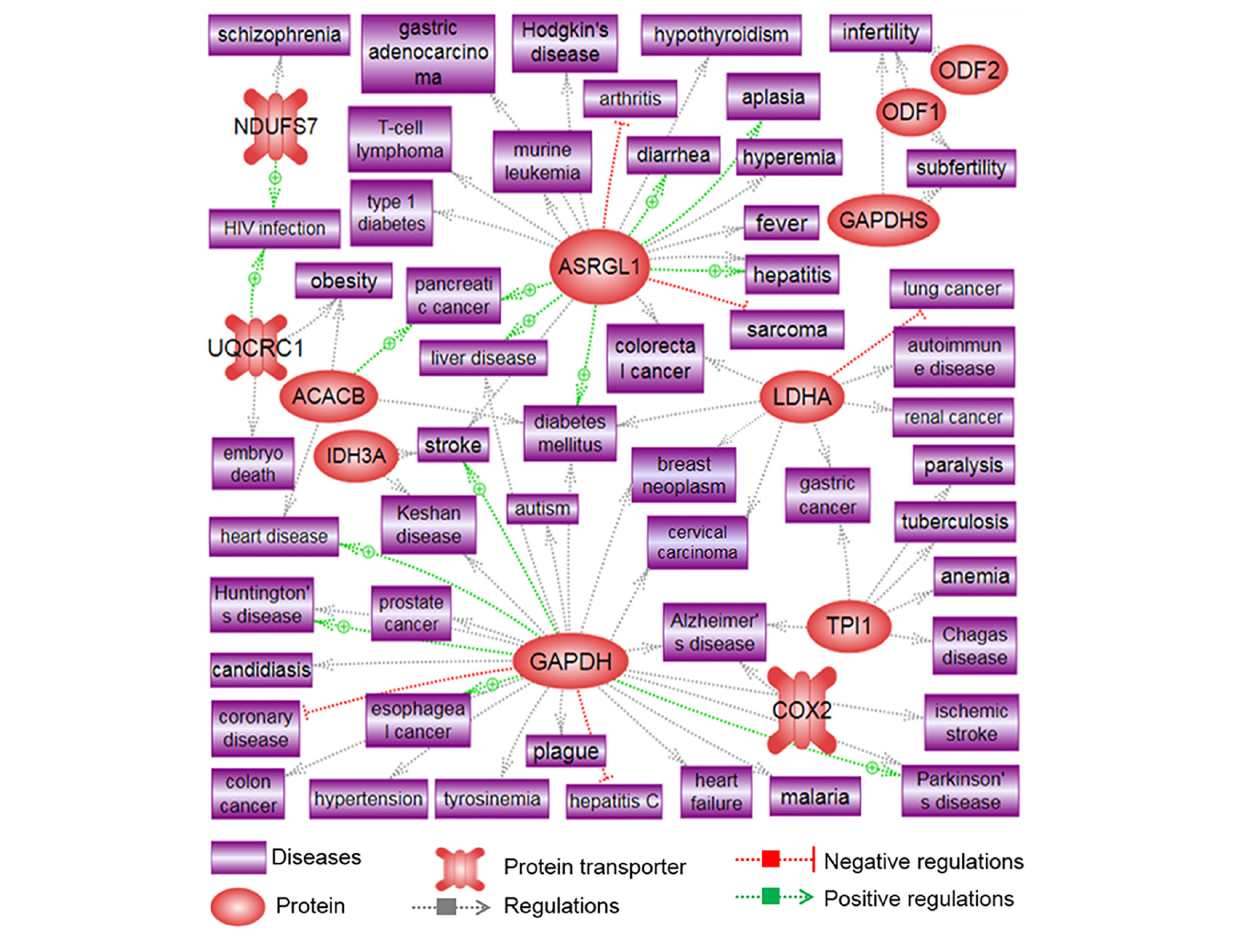
FIGURE 2 | Signaling pathways associated with highly differentiated proteins in X spermatozoa. The illustration was prepared using Pathway Studio (Elsevier R (cid:13) , Ariadne Genomics, Inc.) after performing a literature search in the PubMed database.